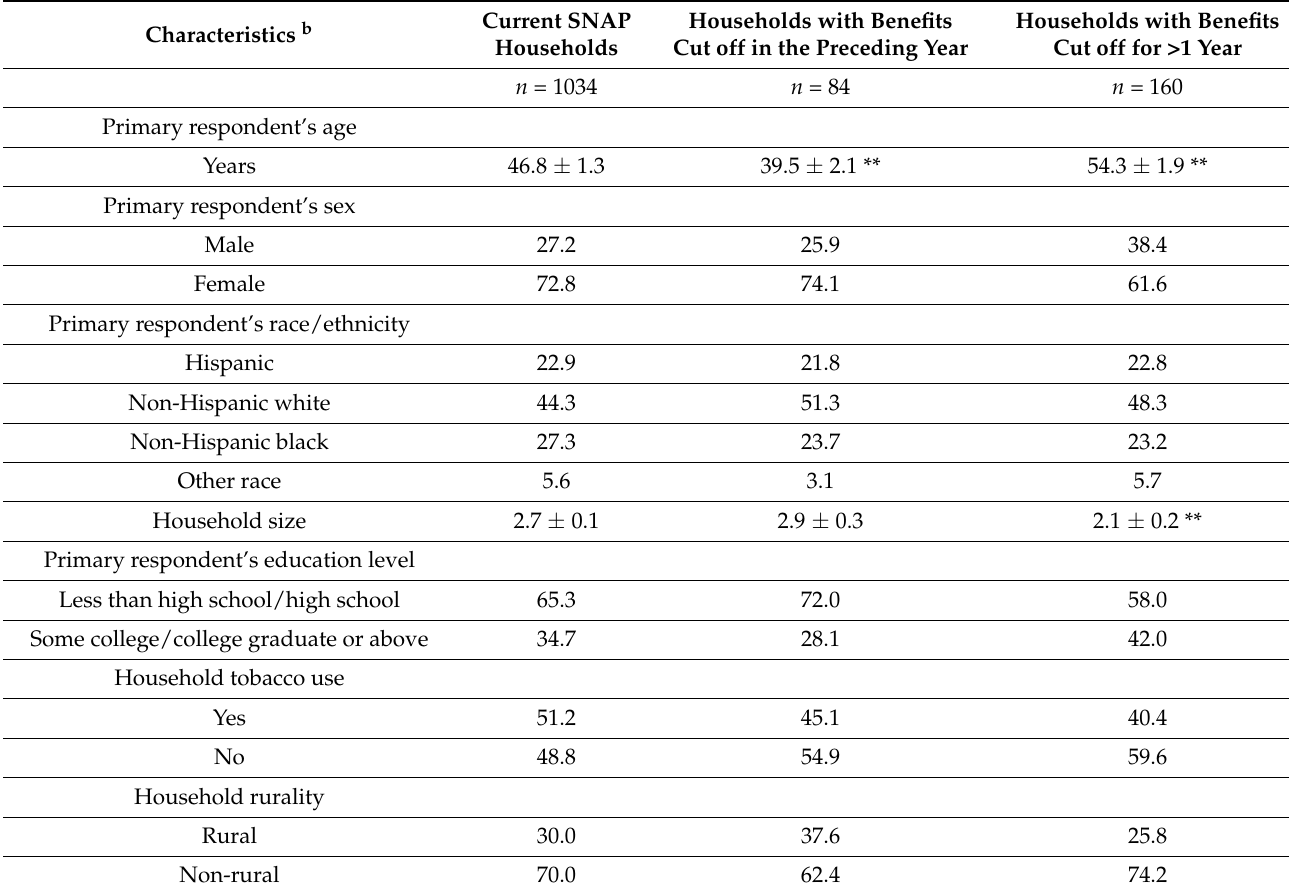
Table 1. Demographic characteristics a of income-eligible households by participation in the Supplemental Nutrition Assistance Program